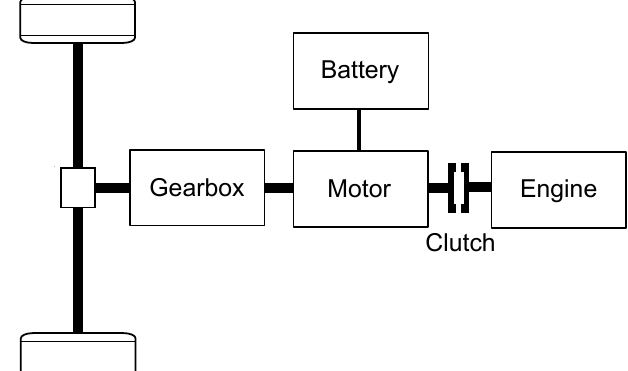
Figure 1. A hybrid electric vehicle (HEV) architecture considered in this paper: pre-transmission parallel